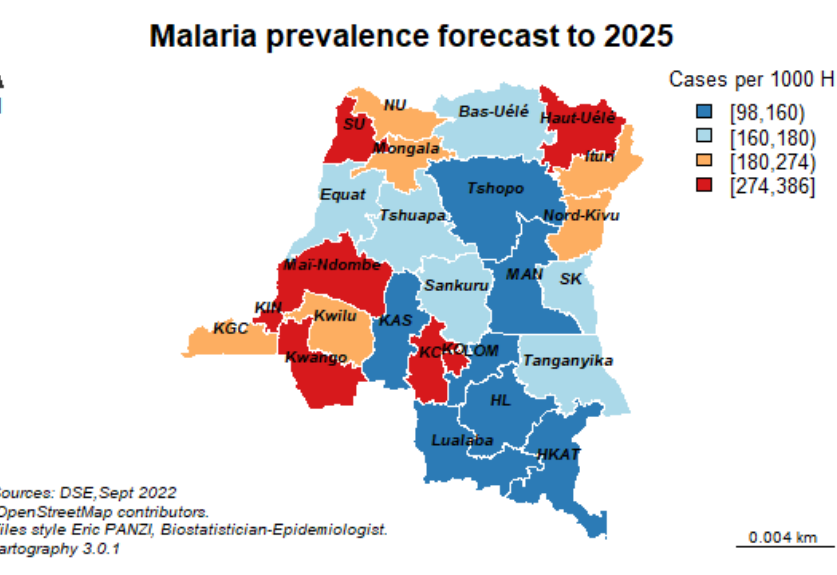
Figure A2. Malaria prevalence forecasts to 2025.